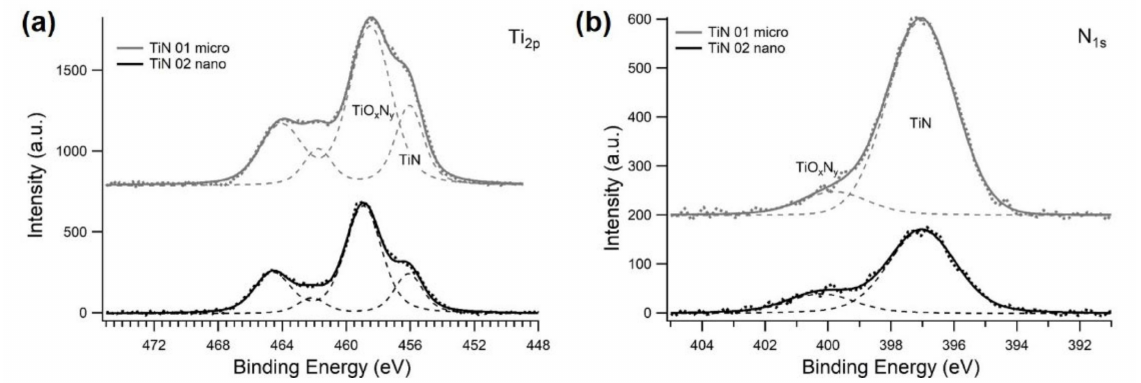
Figure 4. ( a ) Ti 2p XPS spectra of as-received micro- (grey color) and nano-TiN (black color) powders. The spectra are shown decomposed into Voigt-doublets (dash curves), according to the spin-orbit splitting of Ti 2p levels. ( b ) N1s spectra of as-received micro- (grey color) and nano-TiN (black color) powders. Dash curves show the deconvolution of